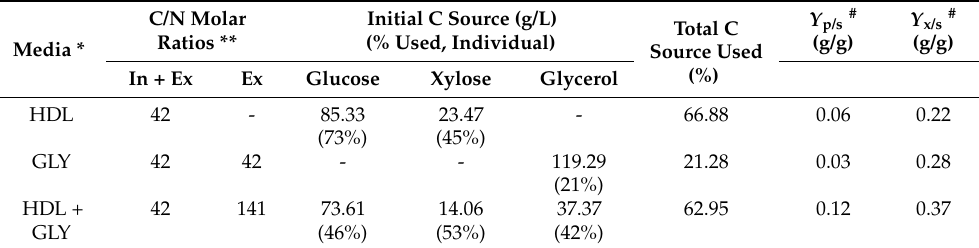
Figure 1. Sugars and glycerol profiles in cultivation of R. glutinis 5159 in hydrolysate (HDL), glycerol (GLY) and hydrolysate mixed with glycerol (HDL + GLY). Table 2. Carbon use, yield of lipid and cell when cultivation of R. glutinis 5159 in hydrolysate (HDL), glycerol (GLY) and hydrolysate mix with glycerol (HDL+GLY) at 30 ◦ C with orbital shaking at 200 rpm for 144